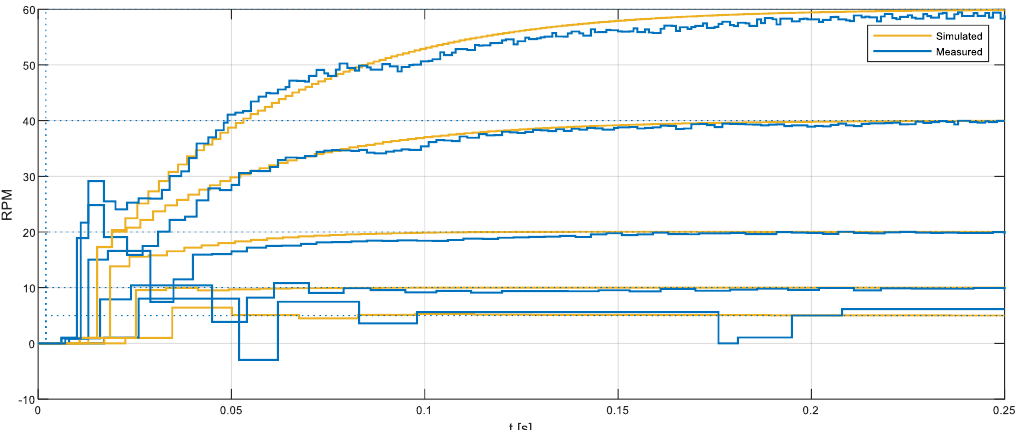
Figure 18. BDCM output in a closed-loop PID control: real evolution of the angular rotational velocity measured from the information gathered by the magnetic quadrature encoder (blue line) and simulated motor velocity (yellow line). Response to steps with target speeds of 5, 10, 20, 40, and 60 rpm.